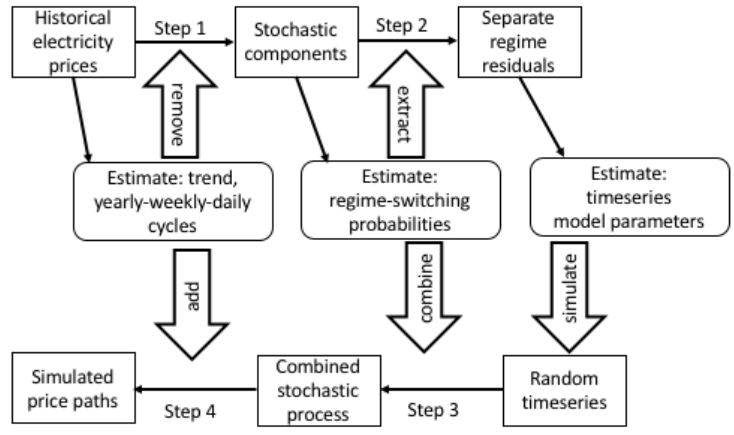
Figure 2. Overview of the price estimation/simulation model.